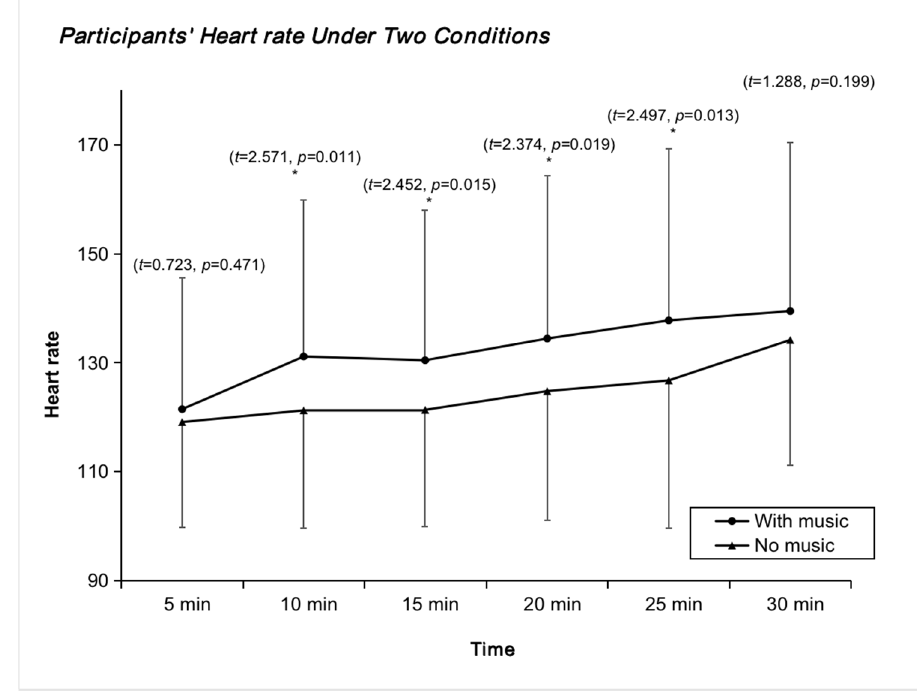
Figure 1. Trend of HR indicators in the presence and absence of music. * p < 0.05.